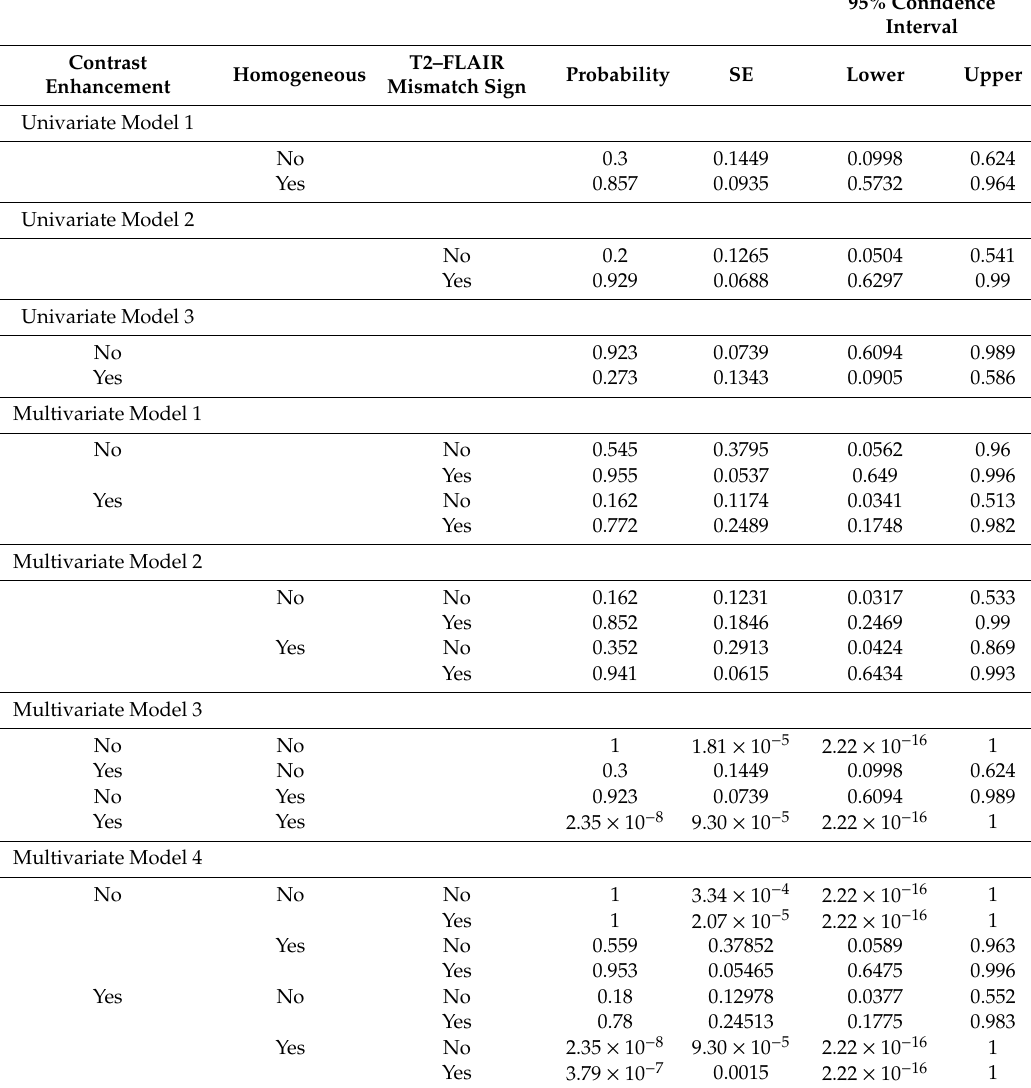
Table 5. Estimated marginal means table. Probability of IDH mutation in association with various radiological